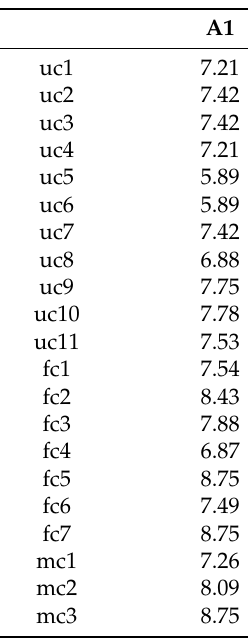
Table 5. The data of the evaluation.